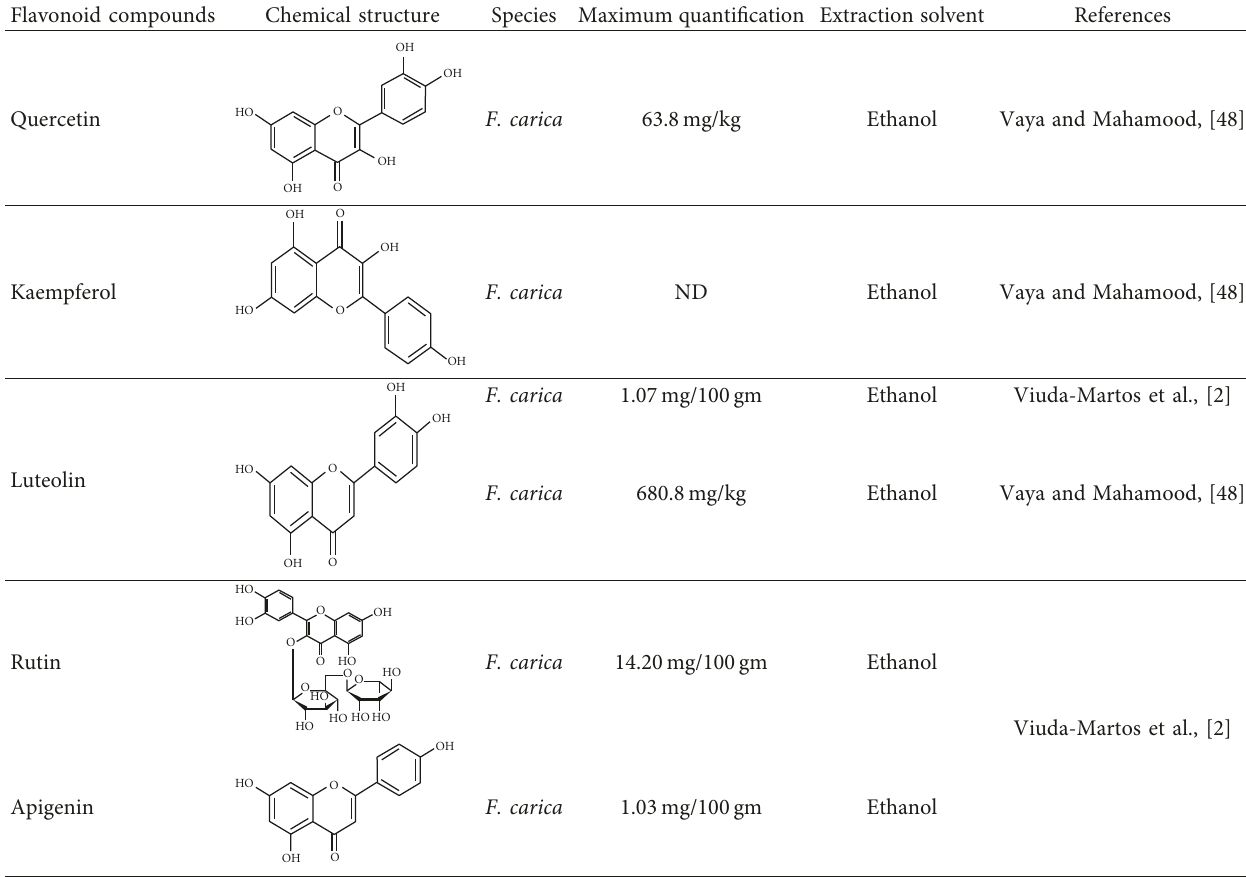
Table 5: Flavonoid compounds present in the species used as both fresh fruit and species belonging to genus Ficus . Flavonoid compounds